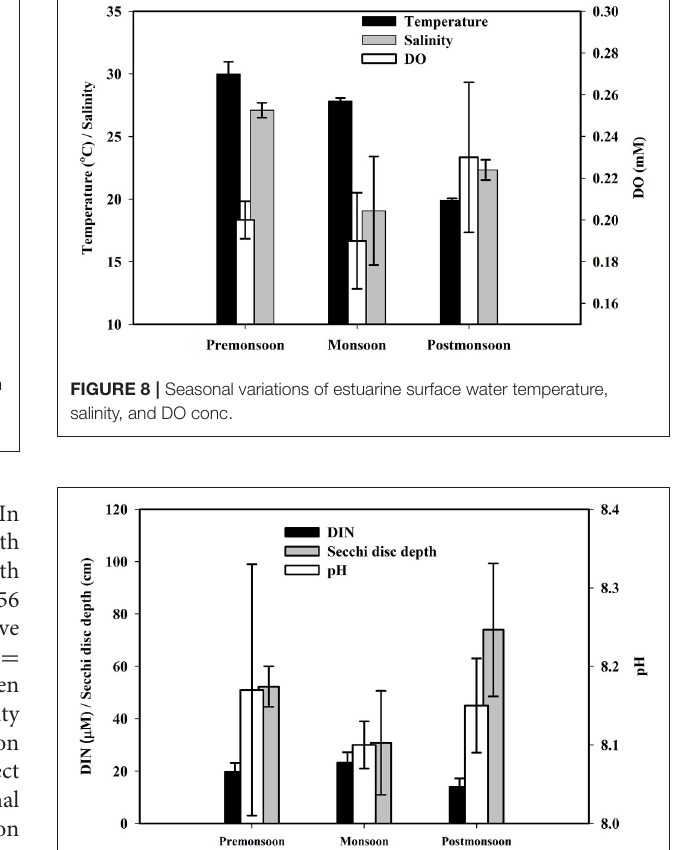
FIGURE 9 | Seasonal variations of estuarine surface water DIN conc., pH and secchi disc